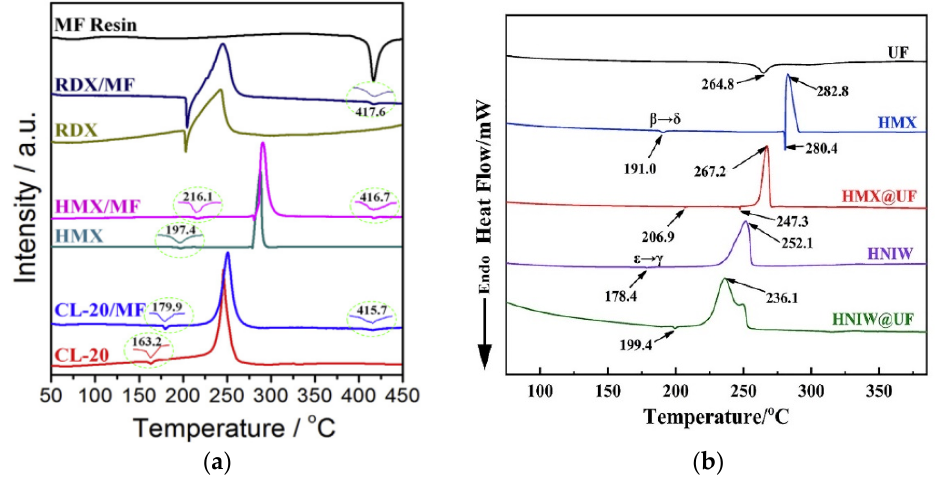
Figure 6. DSC curves of explosives coated by MF ( a ) and UF resin ( b ), respectively (The heating rate is 10 °C/min in ( a , b ). ( a ) Reproduced with permission from [60], copyright 2015, Elsevier. ( b ) Reproduced with permission from [61], copyright 2019, Elsevier.